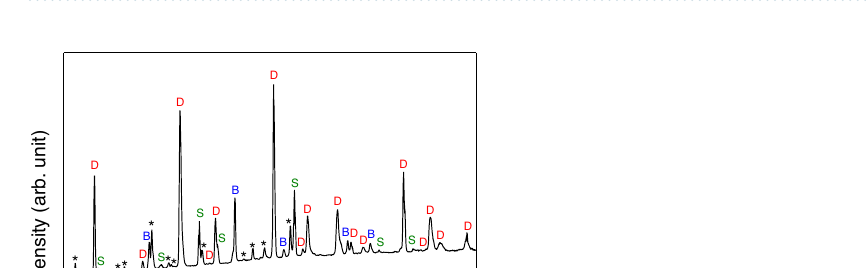
Table 1. Conditions of the high-pressure experiments. T max target maximum temperature, T q quenching temperature.